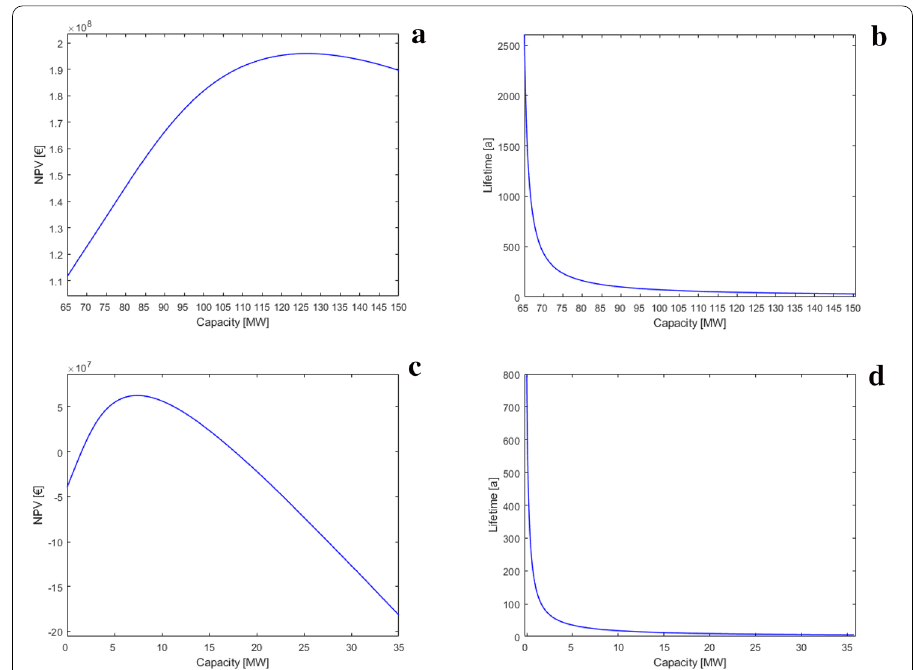
Fig. 3 NPV and reservoir lifetime in dependence of installed capacity. a NPV as a function of installed capacity (Case 1); b lifetime as a function of capacity (Case 1); c NPV as a function of installed capacity (Case 2); d lifetime as a function of capacity (Case